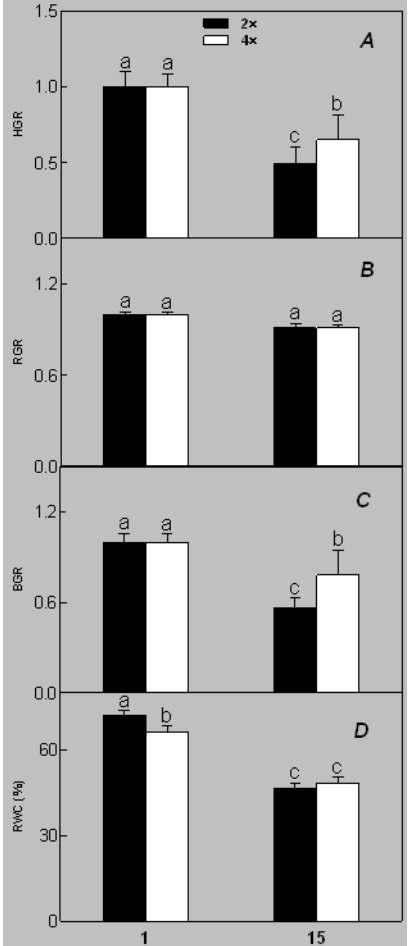
Figure 2. Effects of salt stress on relative height growth rate (HGR) ( A ), relative range growth rate (RGR) ( B ), relative basal diameter growth rate (BGR) ( C ), and relative water content (RWC) ( D ) of leaves in Robinia pseudoacacia diploid (2×) (black bars) and tetraploid (4×) (white bars) plants growing under salt stress. Values followed by different letters are significantly different from each other at p < 0 . 05 according to Duncan’s method. Each data point represents the mean ± standard error of three